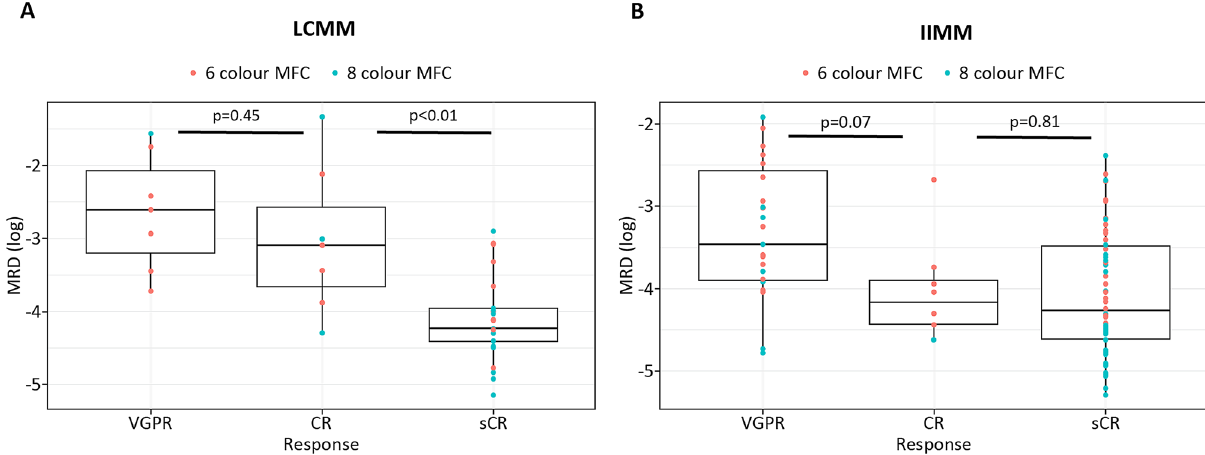
Figure 2. Measurable residual disease (MRD) according to best response as defined by IMWG. ( A ) LCMM, ( B ) IIMM. IIMM, intact immunoglobulin multiple myeloma; IMWG, International Myeloma Working Group; LCMM, light chain multiple